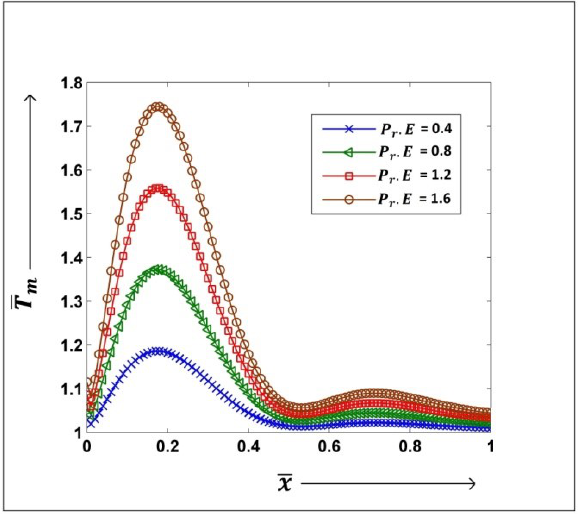
Fig. 7: Mean temperature vs. bearing length for various values of the material parameter at 1/¯ s = 0.5, ¯ β = 1.3, ¯ γ 2 = 1.2, P 0.8